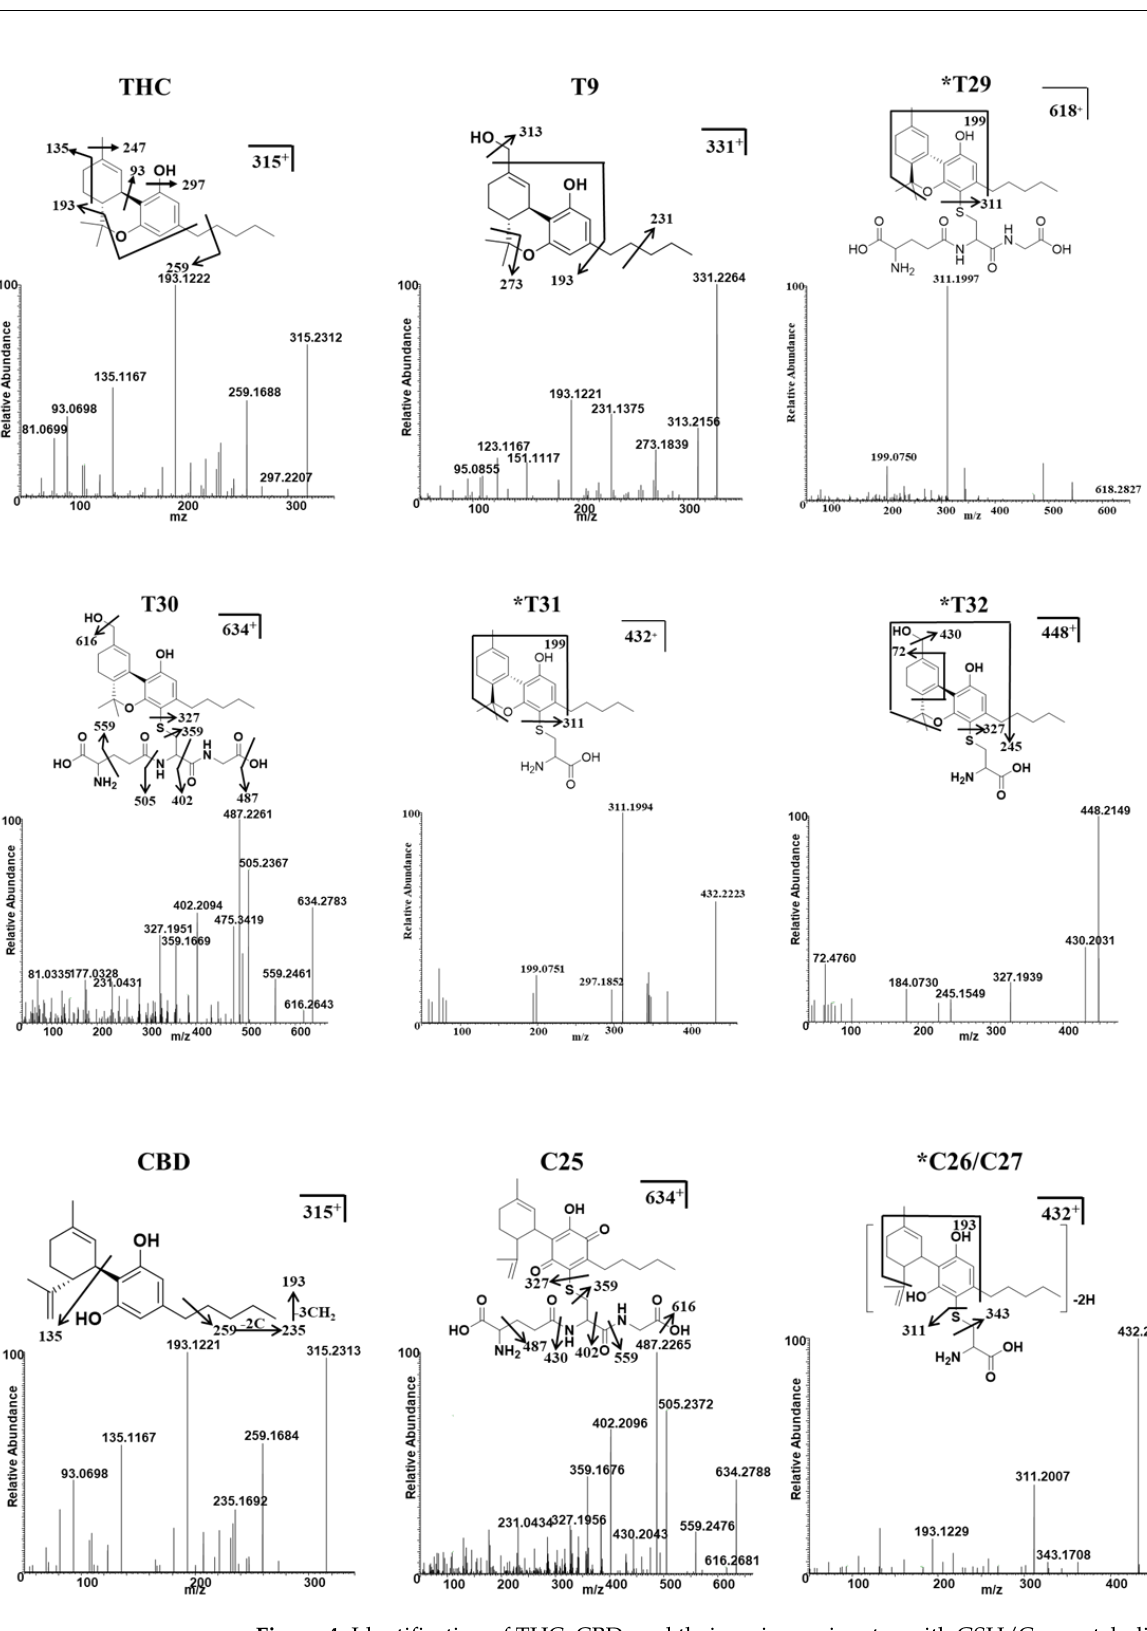
Figure 4. Identification of THC, CBD, and their major conjugates with GSH/Cys metabolites using UHPLC Q-Exactive MS. The MS/MS spectrum and fragmentation patterns of THC, 11-OH-THC (T9), two THC – GSH conjugates (T29 – T30), two THC – Cys adducts (T31 and T32), CBD, one CBD – GSH adduct (C25), and two CBD – Cys conjugates (C26 – C27). * Represents the novel metabolites in this study.